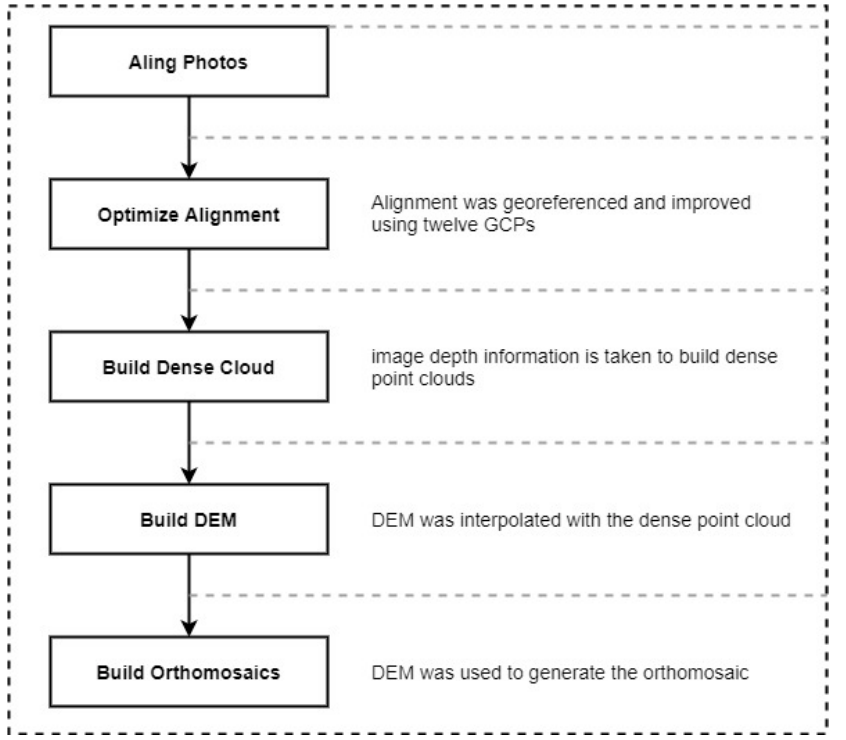
Figure 2. The automated workflow implemented in Pix4D batch-processing. Adapted from